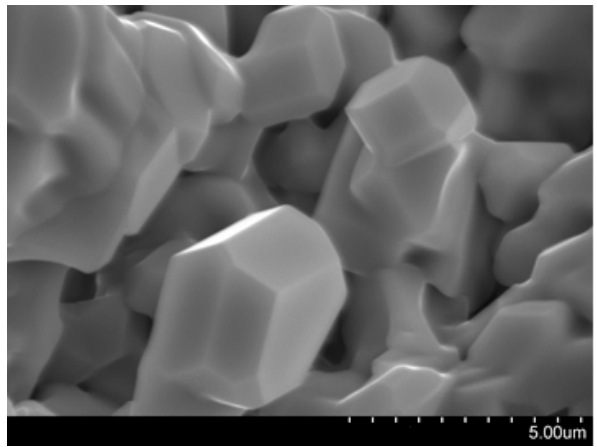
Figure 2. SEM micrograph of La 0.85 Yb 0.25 AlO 3 .